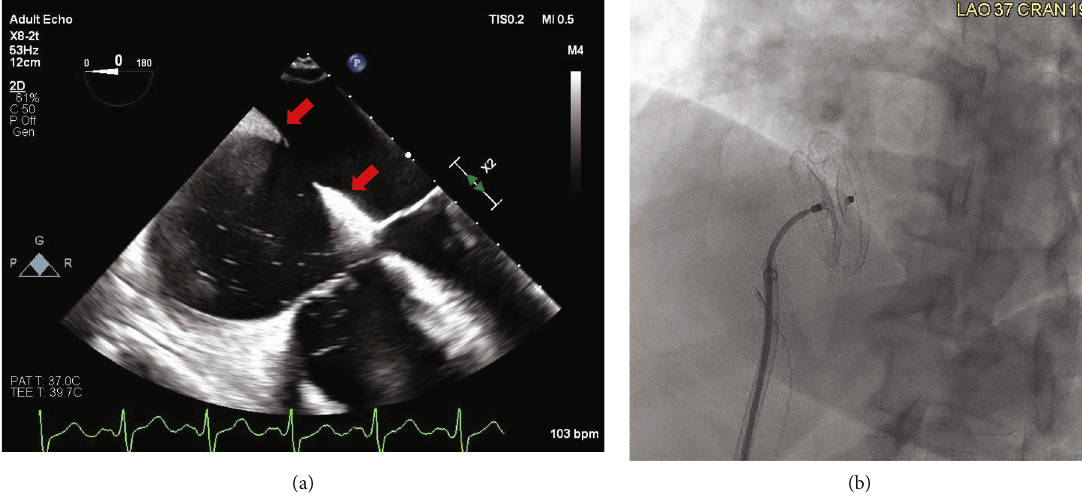
Figure 2: (a) TEE mid-esophageal four-chamber view con fi rming ASD with an adequate rim for percutaneous device closure (arrow). (b) Percutaneous deployment of a 26mm Amplatzer Septal Occlusive device. ASD: atrial septal defect; TEE: transesophageal